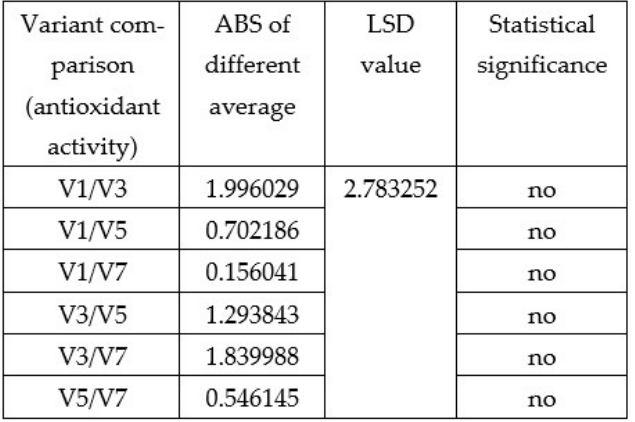
Figure 11. The statistical significance determined by LSD (Least Significant Difference) test values of antioxidant activity in Lepidium sativum L. sprouts cultivated on gauze (V1 control, illuminated with sunlight; V3, illuminated with white LED; V5, illuminated with blue LED; and V7, illuminated with red LED experimental variant), t crit value = 2.306004.